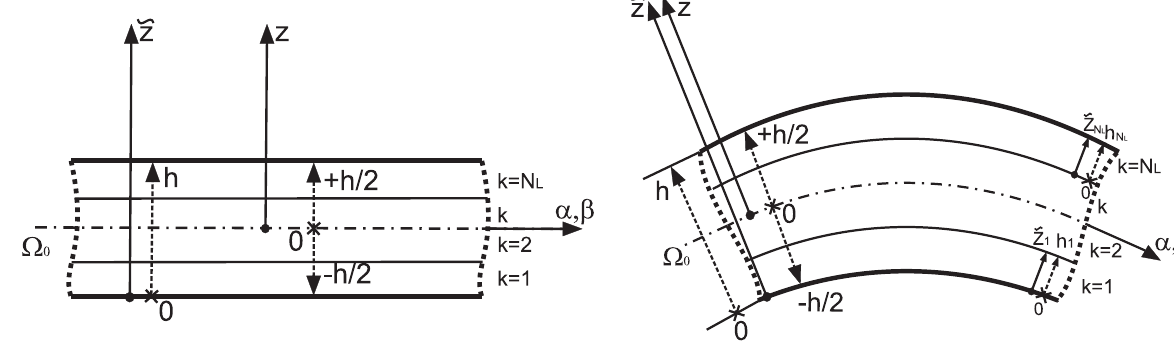
Figure 2: Thickness coordinates and reference systems for plates and shells.